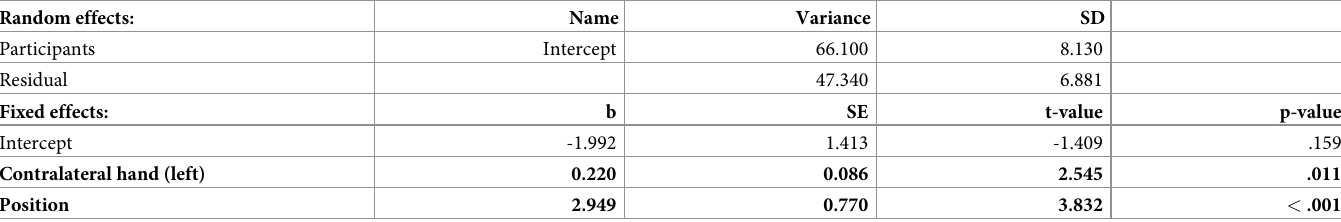
Table 6. Model 1.6. Effect of Position on the right grip force (after controlling for the contralateral force) in the time window 260–1000 ms (Experiment 1). Random